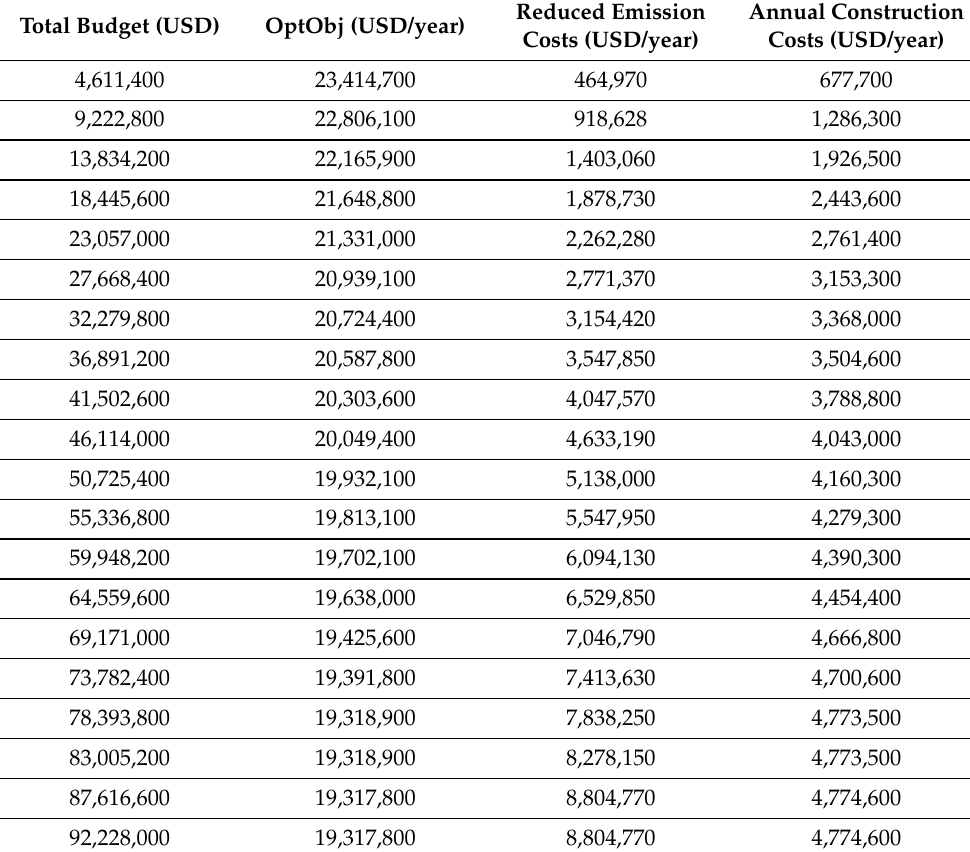
Table 5. Results of sensitive analysis on the total